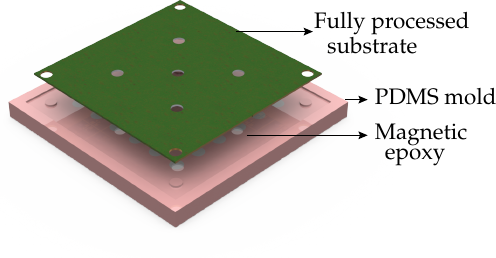
Figure 7. An exploded view of the encapsulation